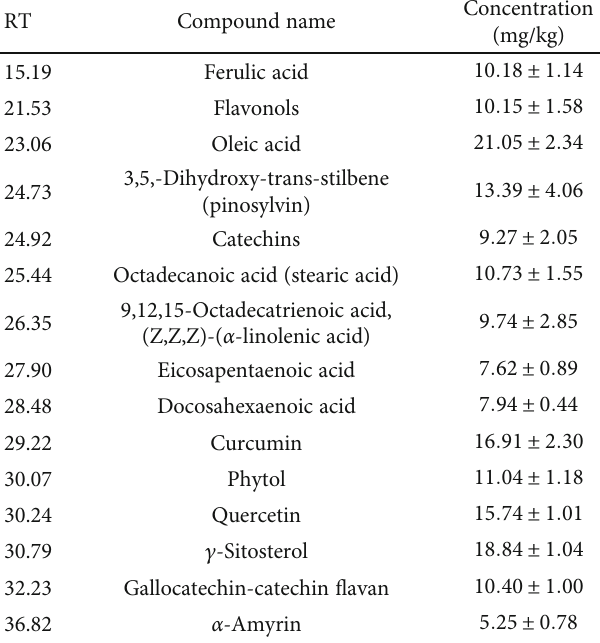
Table 3: Quantity of phytochemical compounds in DCM leaf extract of Gnidia glauca